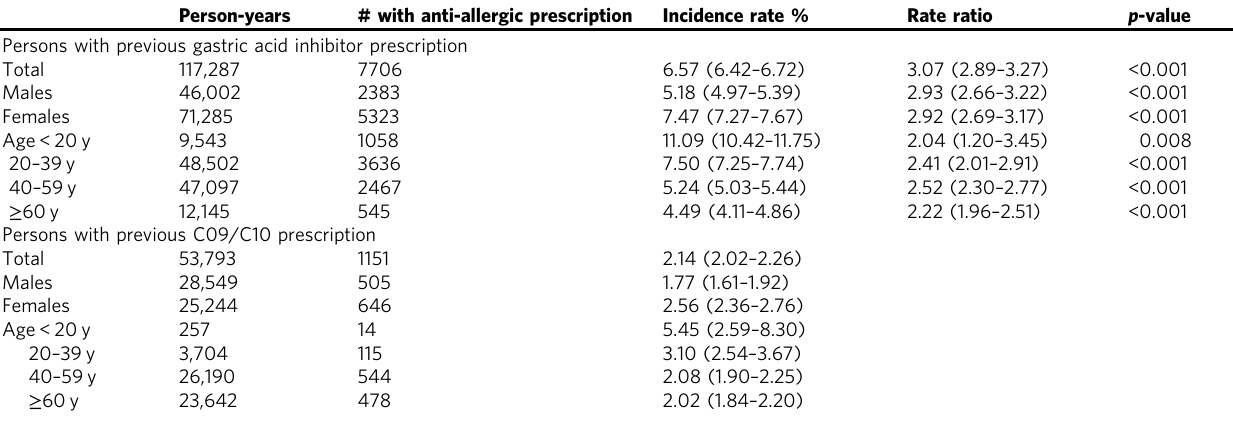
Table 2 Incidence of anti-allergic drug prescription in patients after prescription of gastric acid inhibitors or control medications Person-years # with anti-allergic prescription